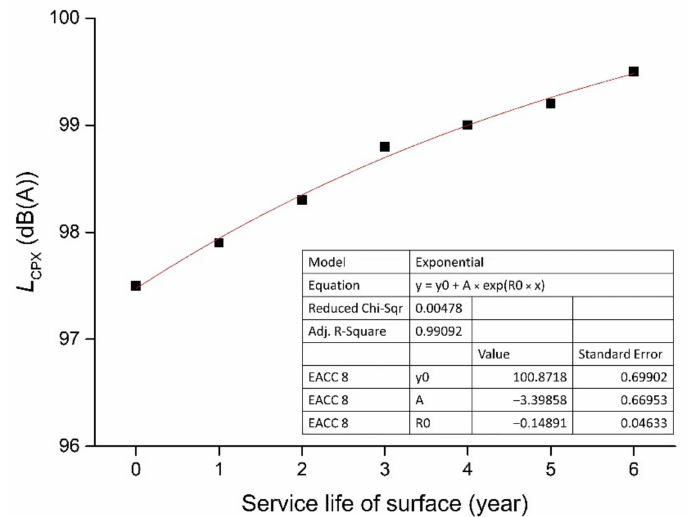
Figure 8. Median noise values for the EACC 8 surface fitted by exponential